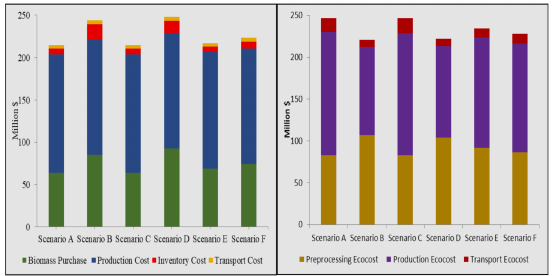
Figure 6. Average annual cost ( left ) and ecocost ( right ) breakdown for the six